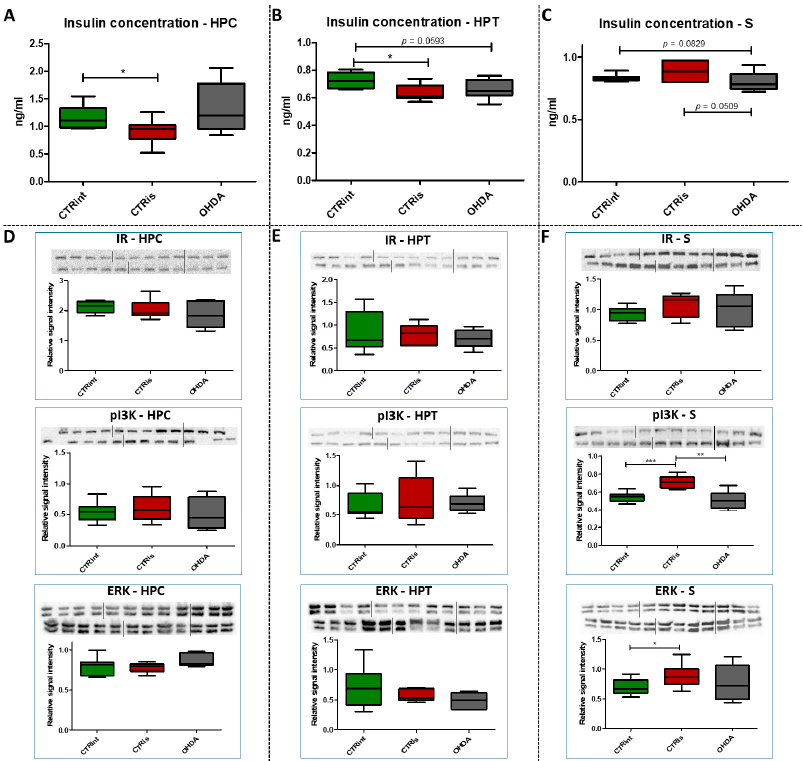
Figure 3. The effect of intrastriatal administration of 6 ‐ OHDA on protein levels involved in insulin signaling. Insulin concentration was measured by ELISA ( A – C ) and protein levels of insulin recep ‐ tor (IR), phosphoinositide 3 ‐ kinases (pI3K) and extracellular signal ‐ regulated kinase (ERK) were measured by Western blot ( D – F ) in the brain of animals 3 months after intrastriatal administration of 6 ‐ OHDA (OHDA) or vehicle only (CTRis) and aged matched intact rats (CTRint). ELISA and Western blot results in the hippocampus (HPC, ( A , D )), hypothalamus (HPT, ( B , E )) and striatum (S, ( C , F )) are represented as a box and whiskers (min to max) plot with between ‐ group differences tested by two ‐ tailed Kruskal–Wallis one ‐ way analysis of variance, followed by the Mann–Whitney U ‐ test, with p < 0.05 considered statistically significant (* p < 0.05, ** p < 0.01, *** p < 0.001). Corre ‐ sponding Western blot images are presented above the plot. n (intact control/CTR) = 9, n (sham operated control/CTRis) = 9, n (OHDA) = 6.